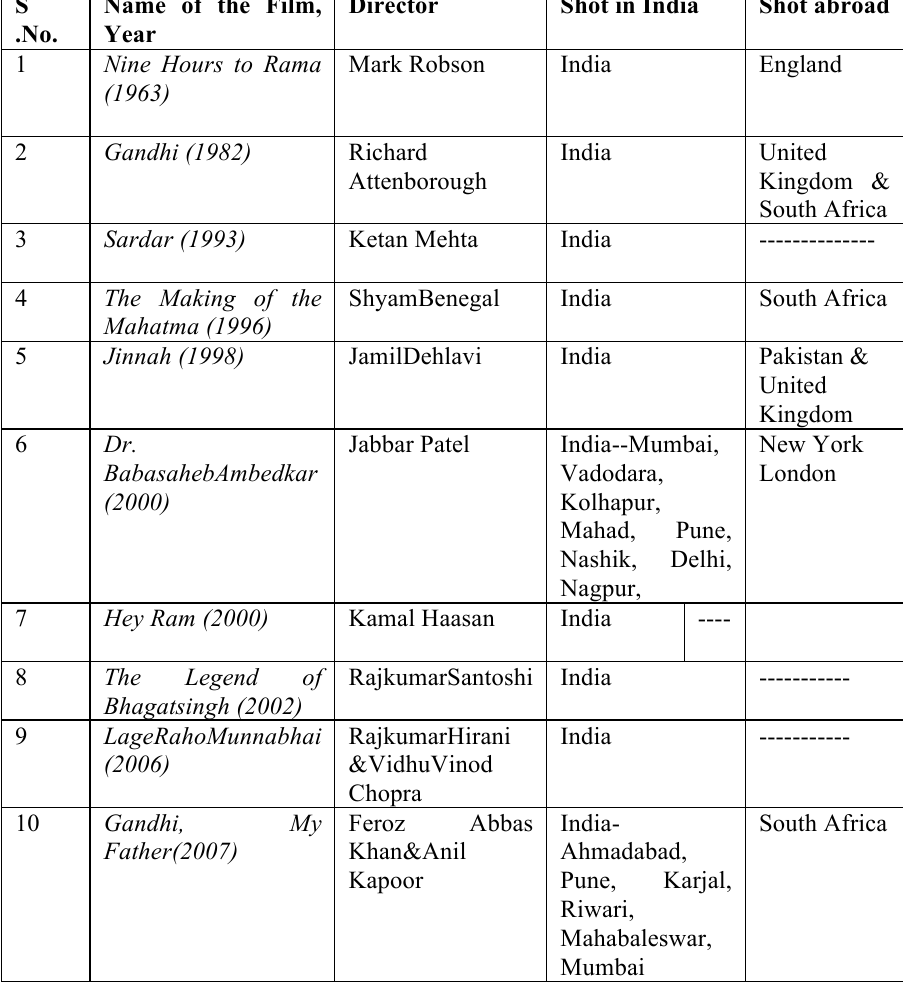
Table 3: Details of the film shooting locations in the universe of Gandhi films. S